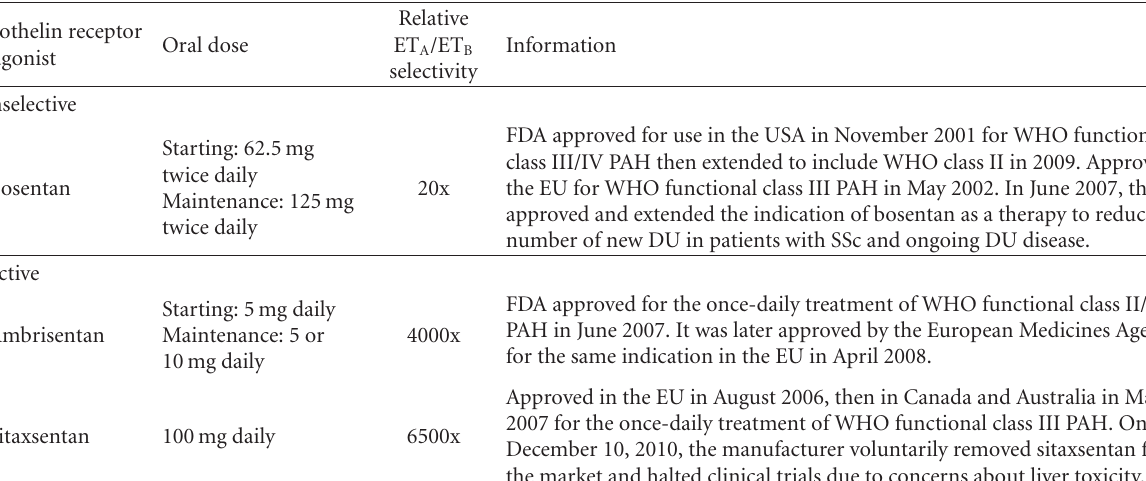
Table 1: Endothelin receptor